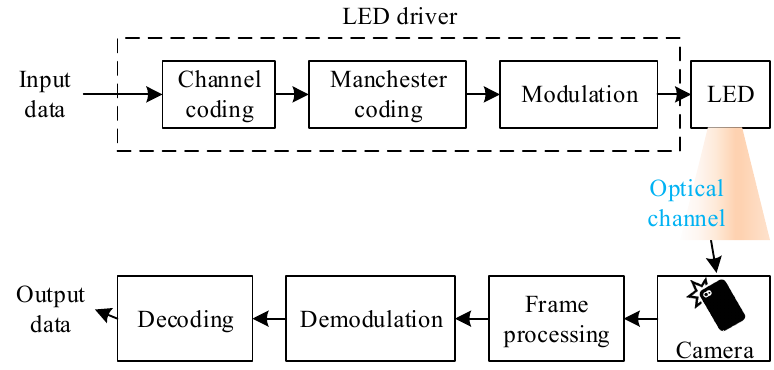
Figure1. Figure 1. The block diagram of an optical camera communication (OCC) transmitter and receiver system.